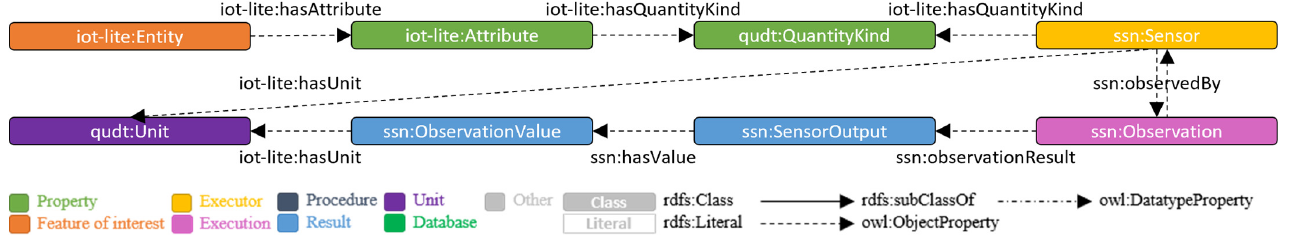
Figure 13. Redundant classes in the Fiesta-IoT pattern.